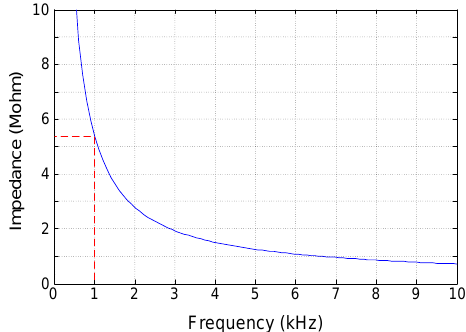
Figure 7. Input impedance of the FCCFN